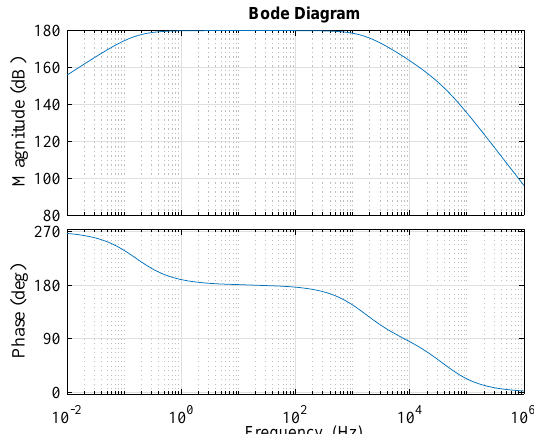
Figure 6. Bode diagram of the signal conditioning circuit.